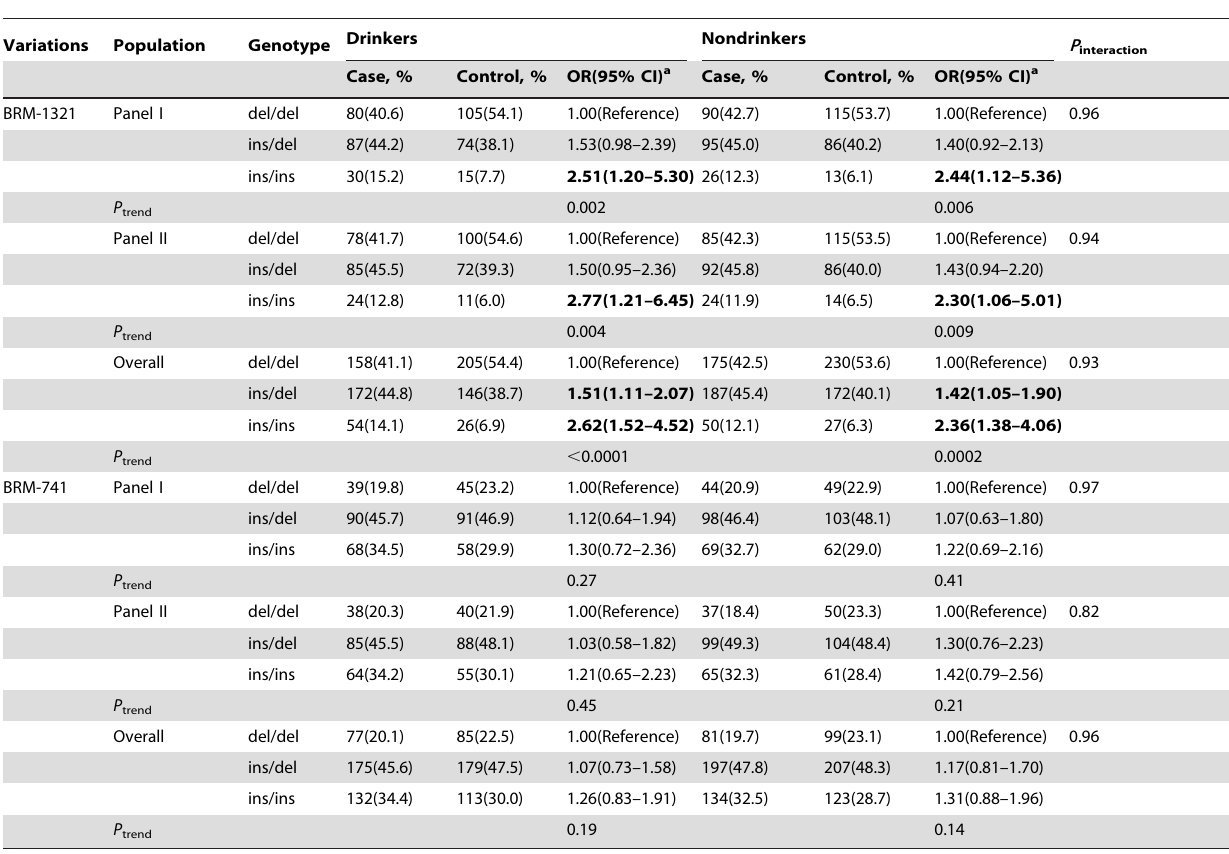
Table 4. Stratification analysis based on drinking status in two populations.